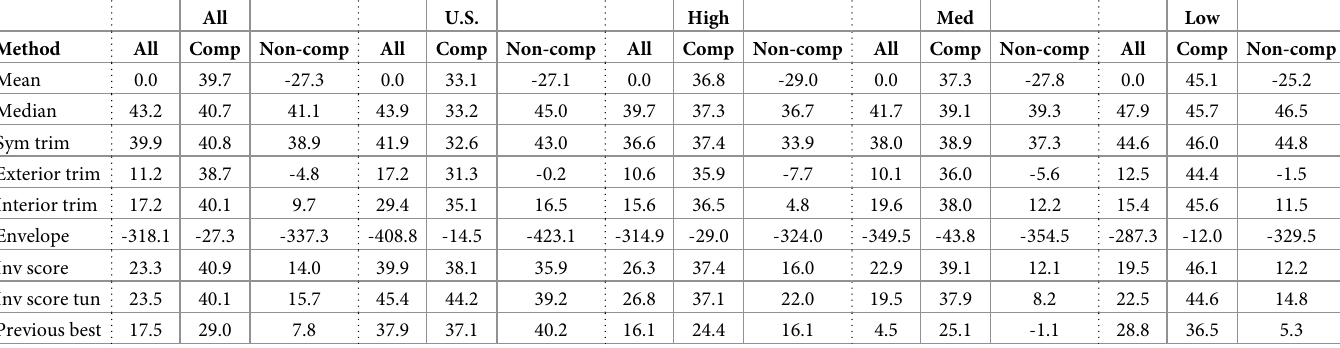
Shows percentage change from the mean. Higher values are better.